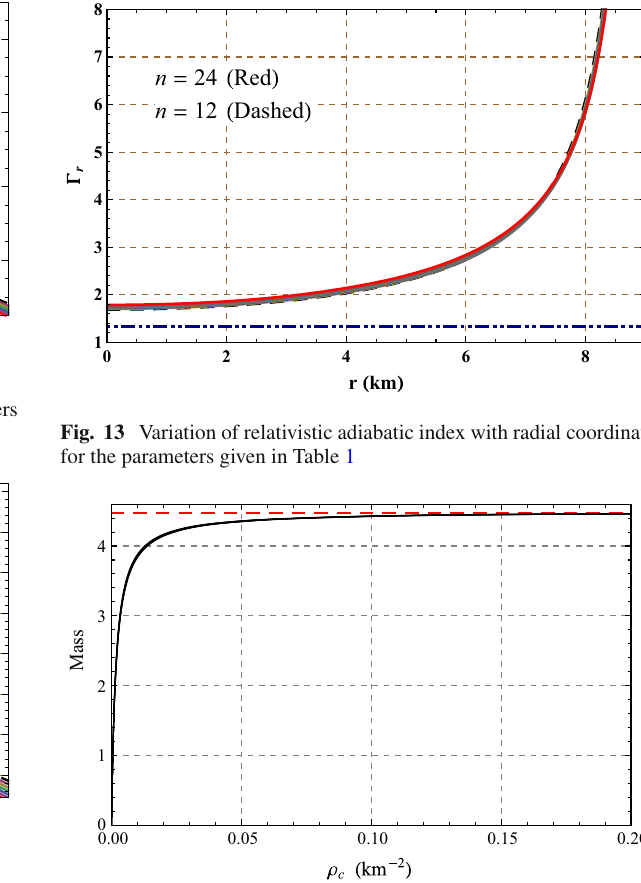
Fig. 11 Variation of ρ − p r − 2 p t with radial coordinate for the param- eters given in Table 1